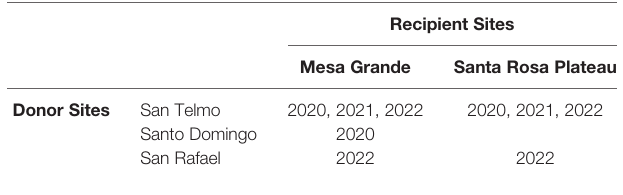
TABLE 2 | Account of years that source and recipient sites were used in translocation of R. draytonii Baja California